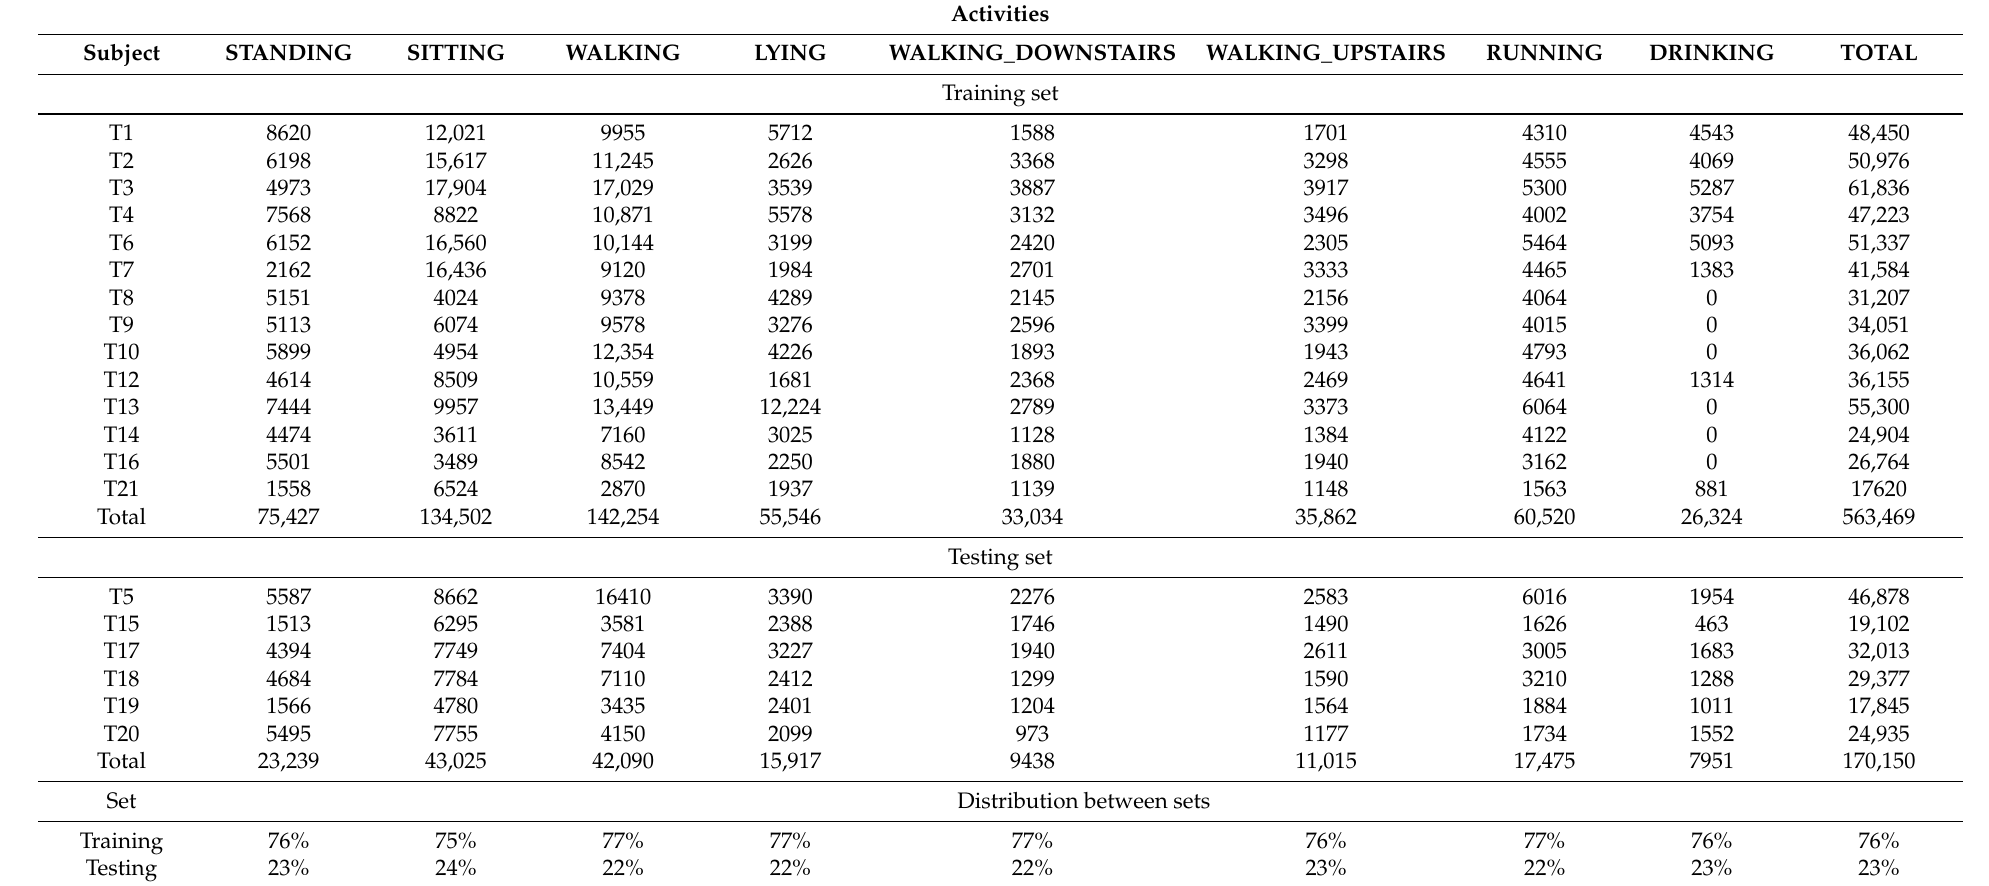
Table A1. Distribution of time samples across subjects and activities for training and testing